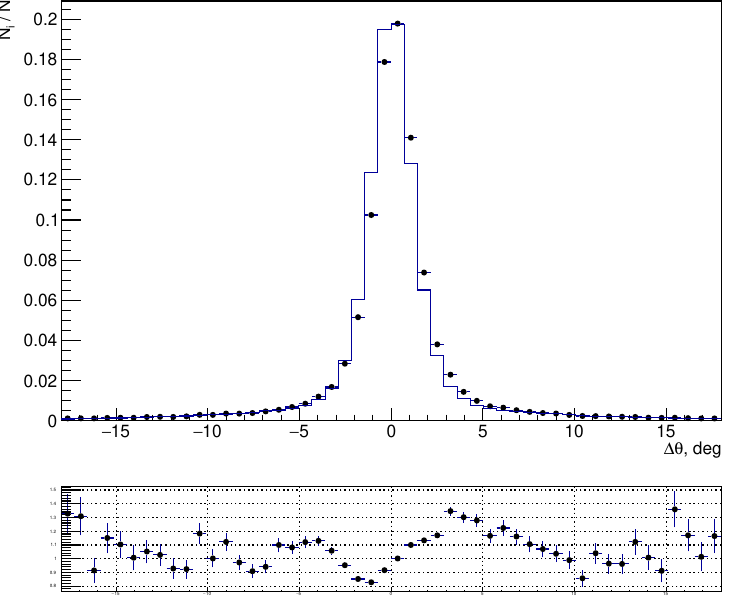
p s = 778 MeV. The solid histogram